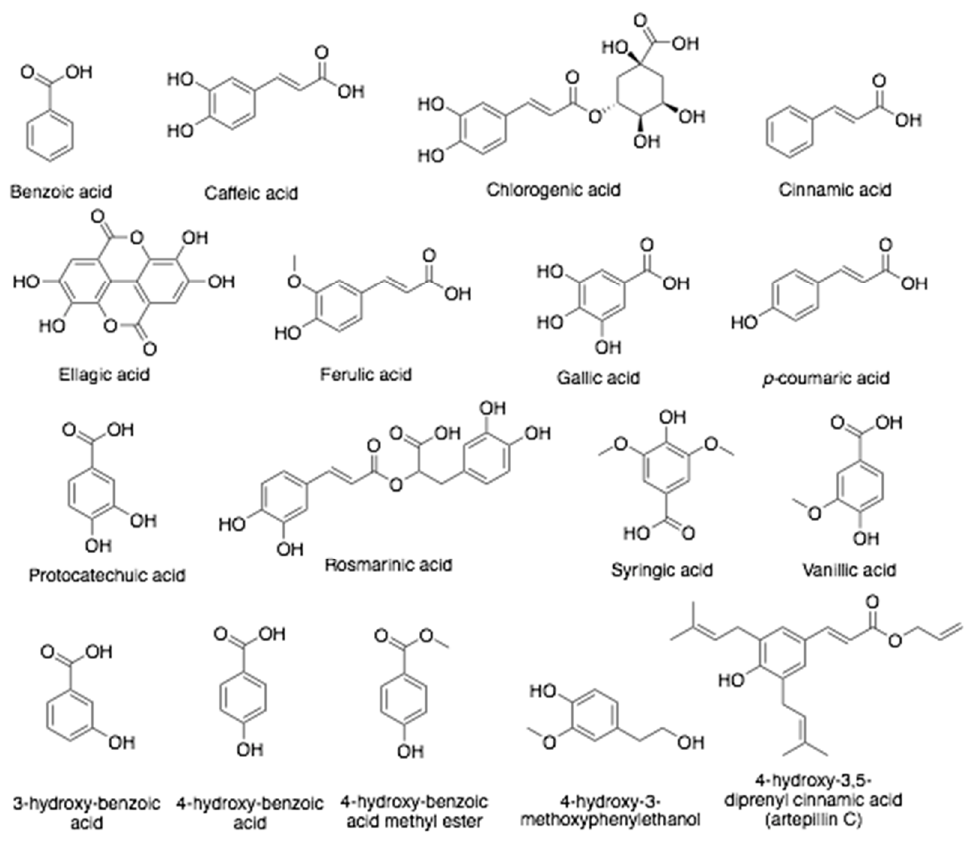
Figure 2. Chemical structures of phenolic acids found in bee products.